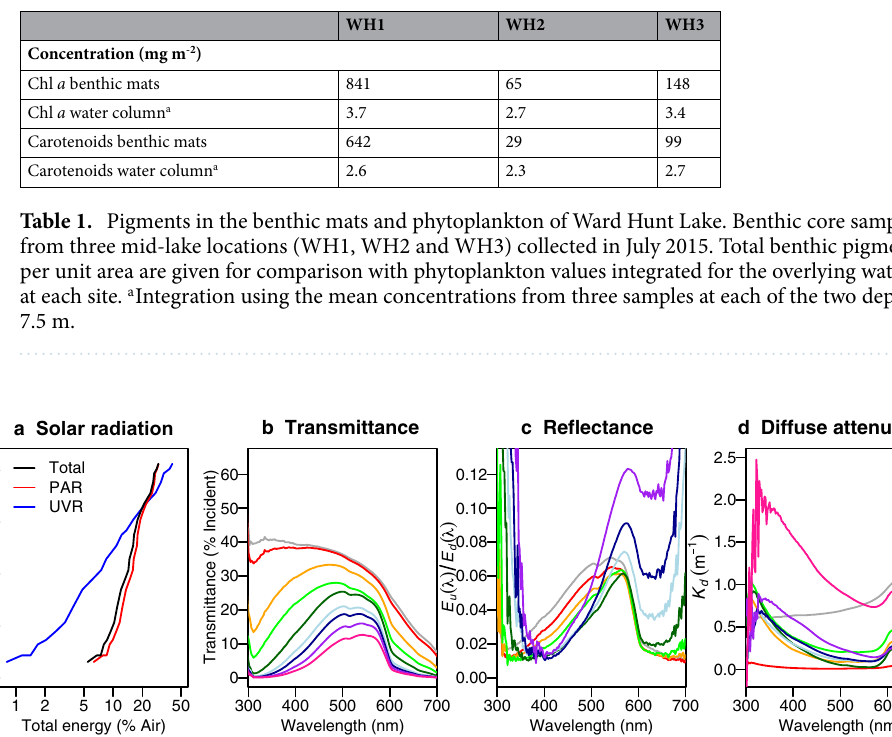
Figure 4. Underwater optical properties. ( a ) Downwelling irradiance for total shortwave, PAR and UVR; ( b ) transmittance as % downwelling incident irradiance in air; ( c ) reflectance as the ratio of upwelling to downwelling irradiance; and ( d ) diffuse attenuation coefficients under the summer ice of Ward Hunt Lake, 14 July 2016. The K d values were plotted at z 2 ; the K d values for just below the ice (JBI) are ‘apparent attenuation coefficients’ because they were not corrected for reflection of incident light by the upper ice